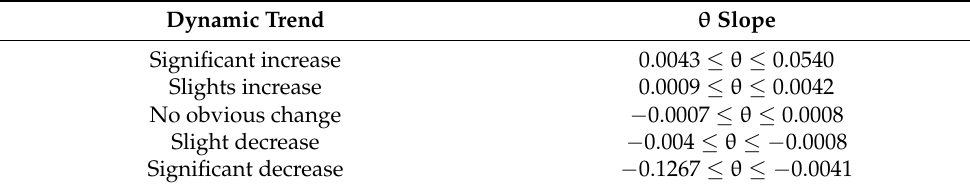
Table 5. Annual mean trend of NDVI for the month of October during the period 2015–2020. Dynamic Trend θ